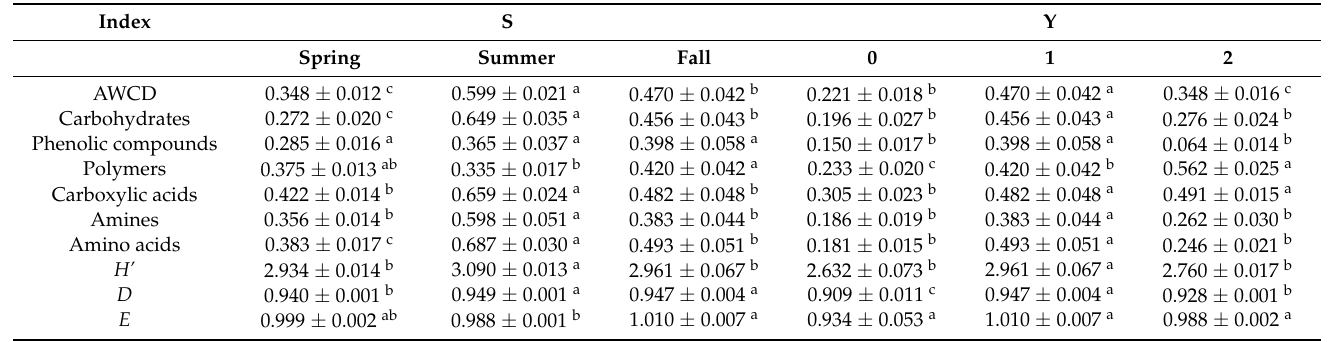
Table A3. Mean ± standard error values for carbon sources and diversity index in different seasons (S) and years